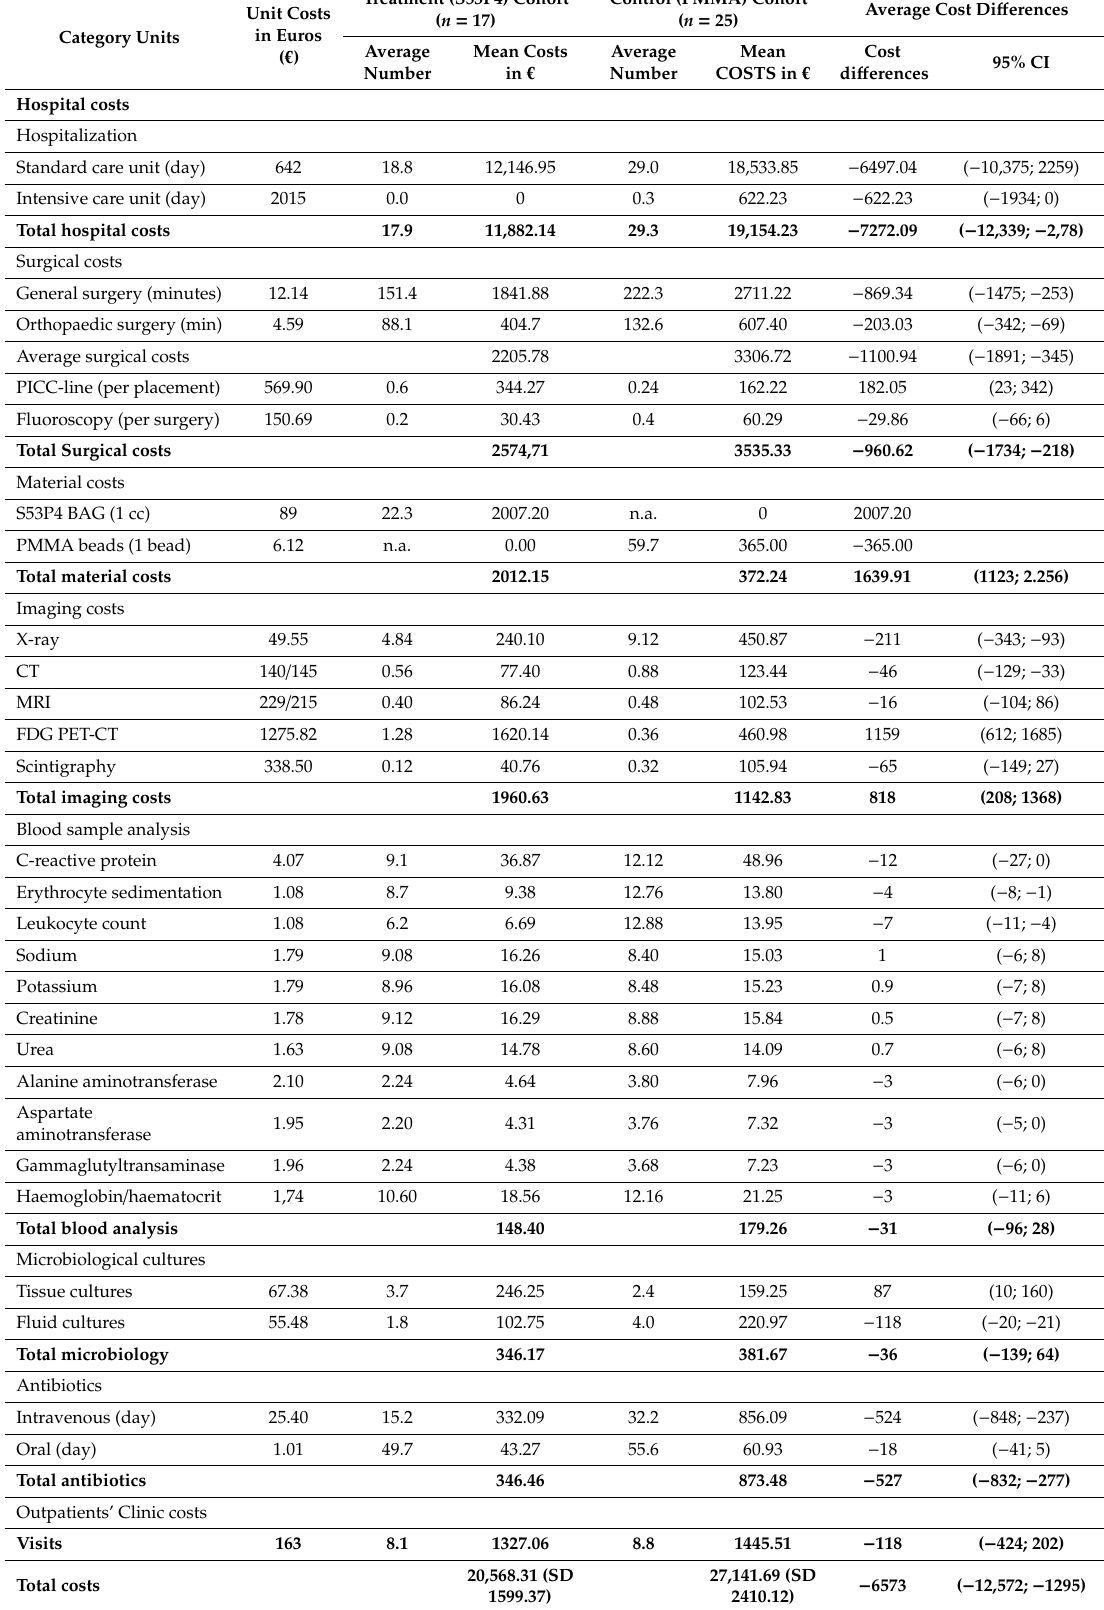
Table 3. Average resource use and costs per category at 12-month follow-up (Bootstrap